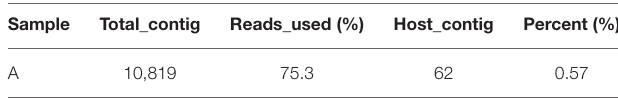
TABLE 2 | Removal of host sequence statistics.